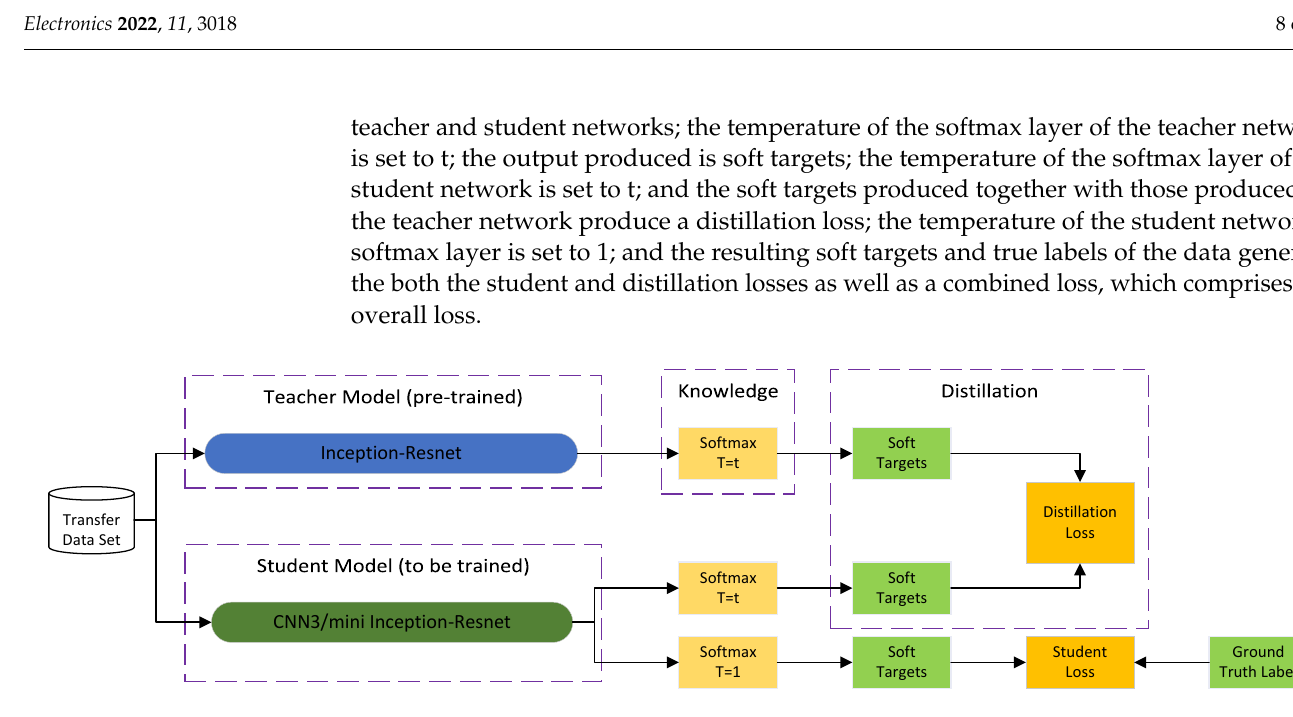
Figure 5. The specific architecture of the benchmark knowledge